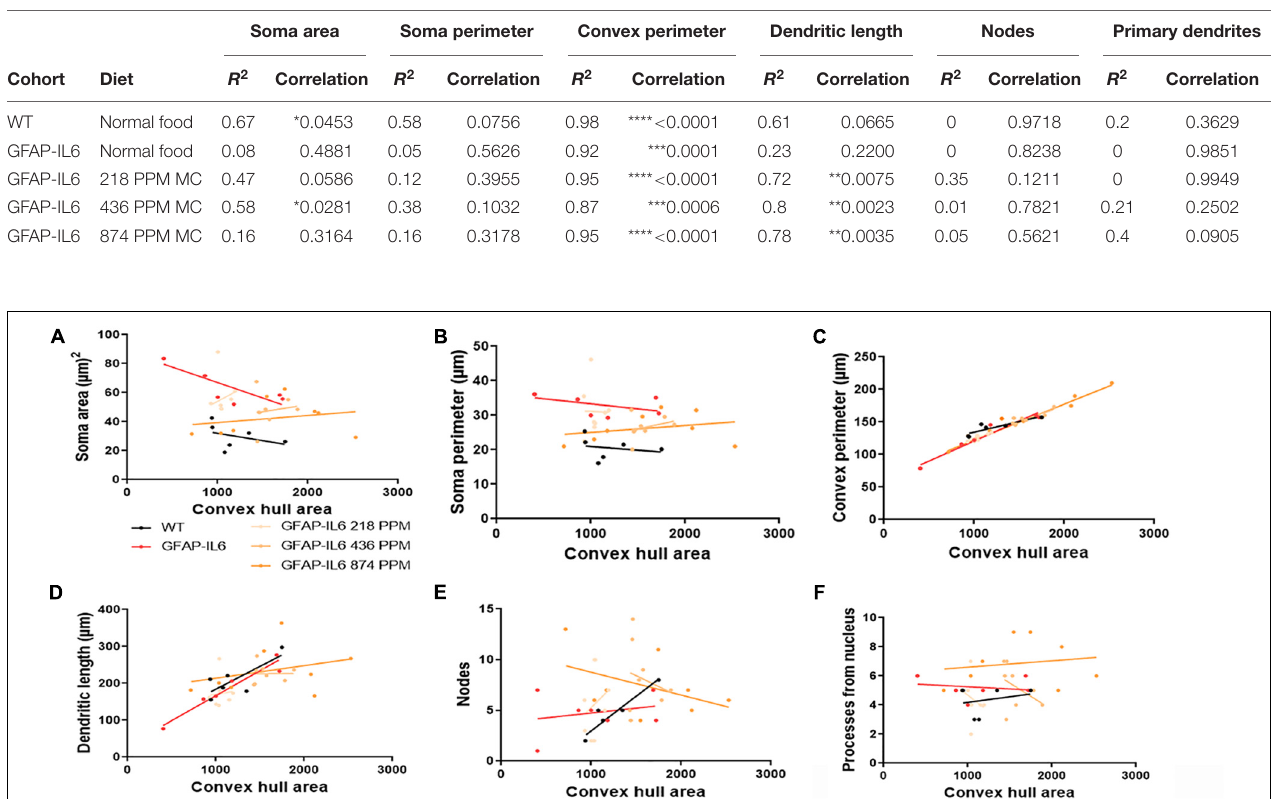
Frontiers in Neuroscience |